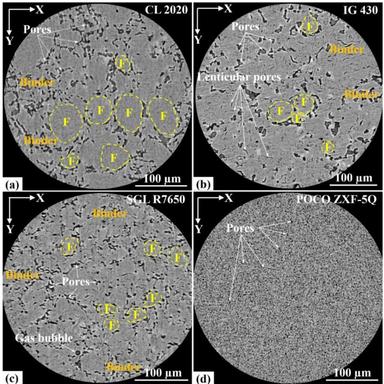
Typical examples of reconstructed μXCT slices showing the porosity distribution in four grades of graphite: (a) CL 2020 graphite, (b) IG 430 graphite, (c) SGL R7650 graphite and, (d) POCO ZXF-5Q graphite. A total number of 1864, 1878, 1895 and 1883 reconstructed μXCT slices have been acquired for each grade respectively, 'F'- filler particles, some selected filler particles are marked as F. (For interpretation of the references to colour in this figure legend, the reader is referred to the web version of th